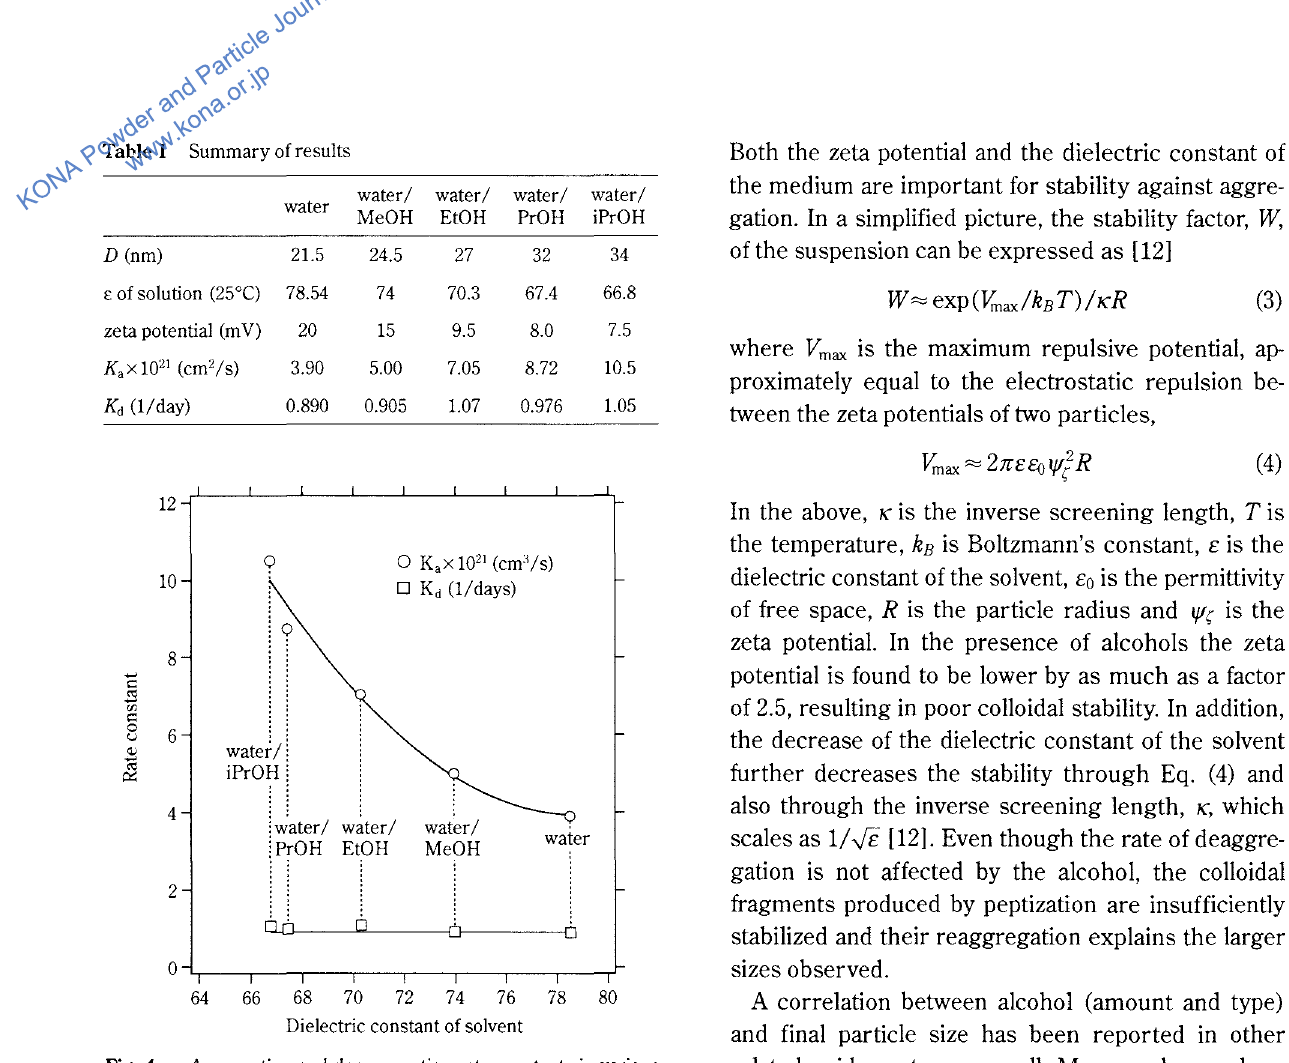
Fig. 4 Aggregation and deaggregation rate constants in various alcohol/water solutions at concentration 3